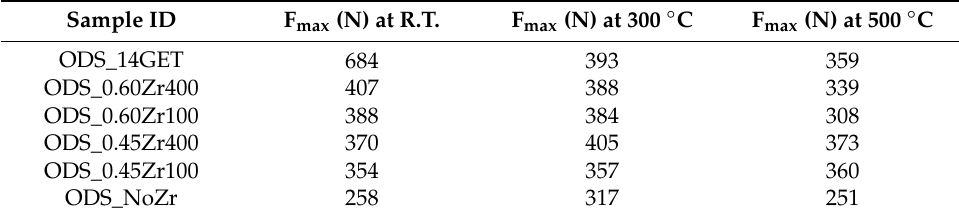
Table 3. Maximum load values reached at di ff erent temperatures during SP